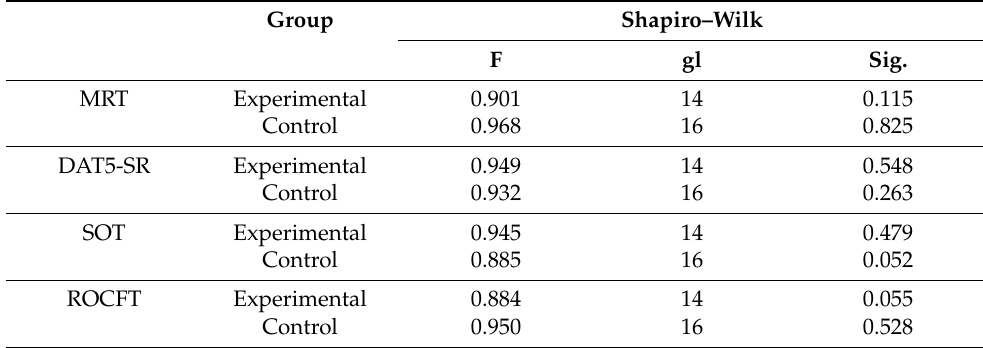
Table 3. Normality test for samples from both groups (experimental group and control group).